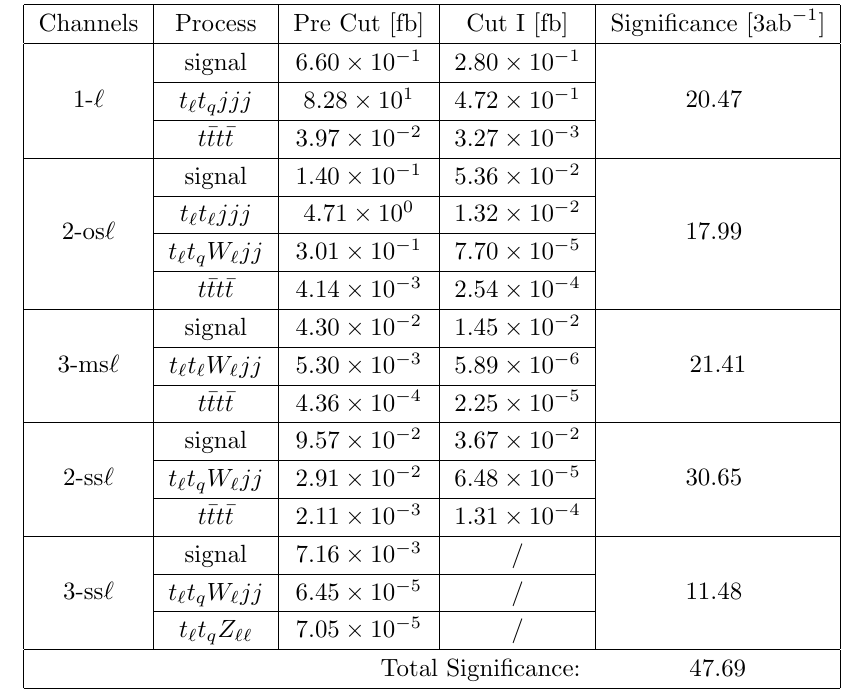
Table 2 . Cut (cid:13)ow for m = 1 : 5 TeV of all (cid:12)ve channels with di(cid:11)erent number of leptons. The t 0 corresponding signi(cid:12)cance with 3 ab (cid:0) 1 luminosity for di(cid:11)erent channels and the combined signi(cid:12)- cance are also list in the last column. Note that for 3-ss ‘ channel, we do not apply Cut I, as the event rate is already extremely low, further selection will decrease the